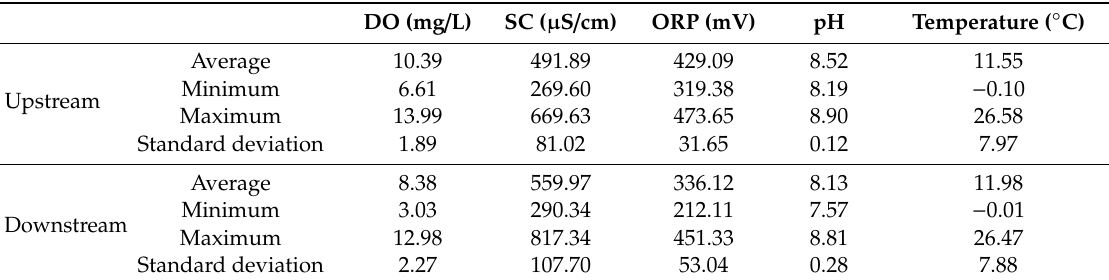
Table 1. Summary of the water quality parameters of Suceava River at the two monitoring stations in 2019 based on daily values. DO (mg / L) SC ( µ S / cm) ORP (mV) pH Temperature ( ◦